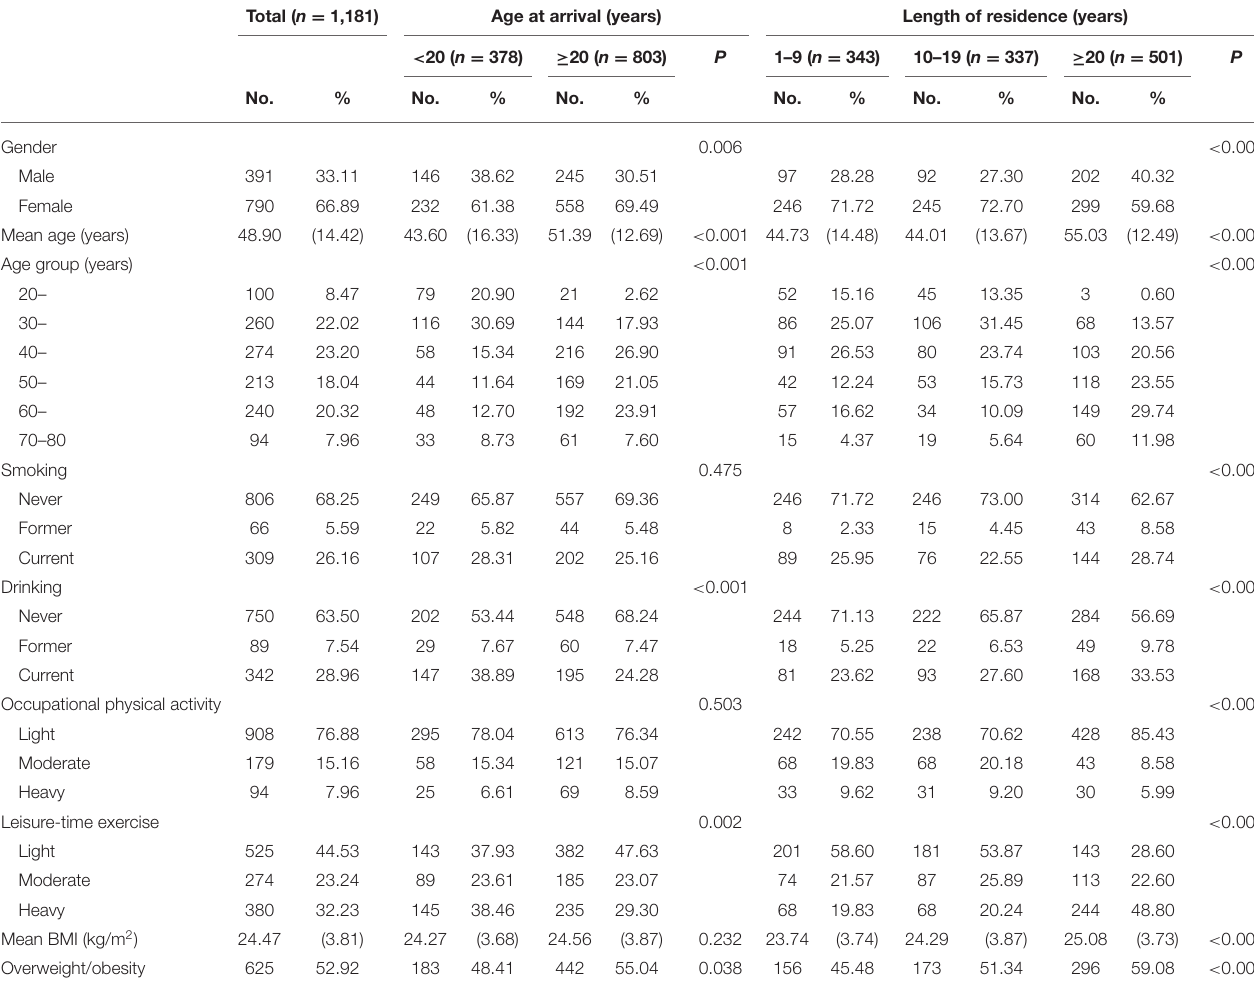
TABLE 1 | Characteristics of the study sample by age at arrival and length of